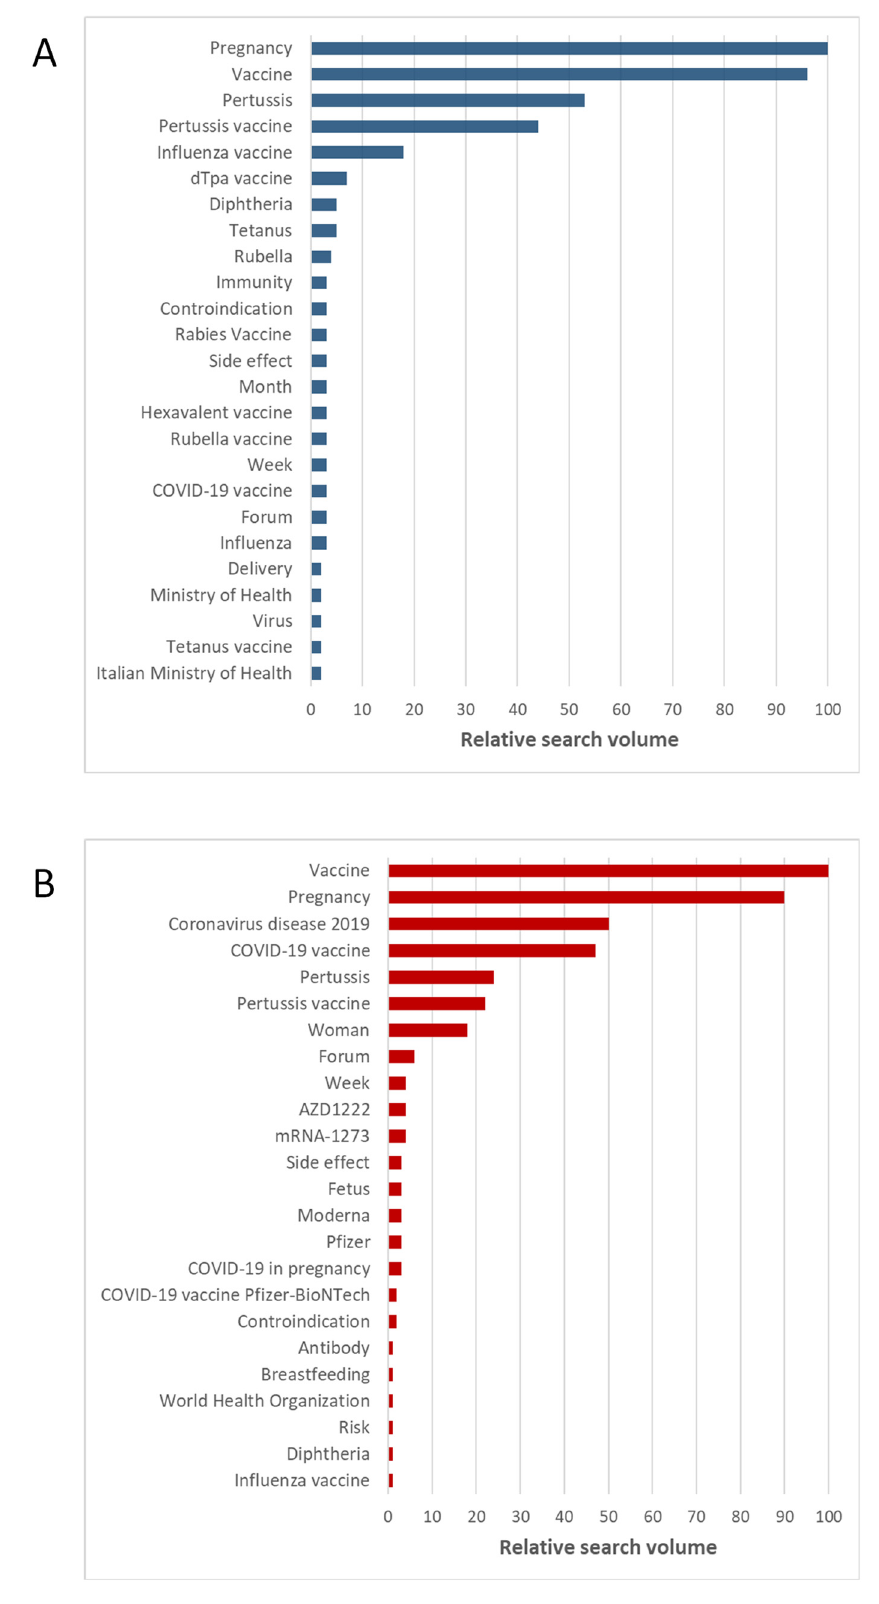
Figure 6. Arguments related to the search activity for the keyword “Vaccine in pregnancy” (Search term). ( A ) Most common arguments before the introduction of COVID-19 vaccination; ( B ) most common arguments after the introduction of COVID-19 vaccination.